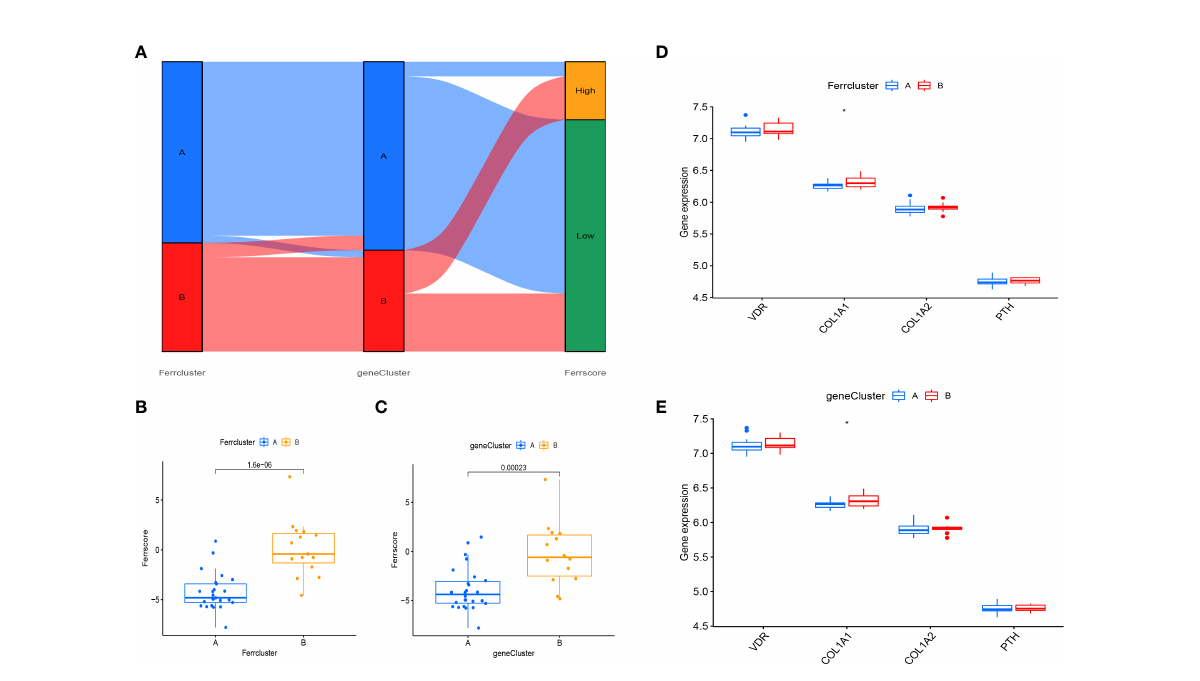
FIGURE 7 Construction of a FAG-Scoring system. (A) Alluvial diagram of subtype distributions in ferroptosis scores with different ferrclusters and geneclusters. (B) Comparison of ferroptosis scores between the ferrcluster A and ferrcluster A and B. (C) Comparison of ferroptosis score between the genecluster A and genecluster A and genecluster B. (D) The expression of VDR gene, COL1A1gene, COL1A2gene and PTH gene between the ferrcluster A and ferrcluster A and ferrcluster B. (E) The expression of VDR gene, COL1A1gene, COL1A2gene and PTH gene between the genecluster A and genecluster B. *P <